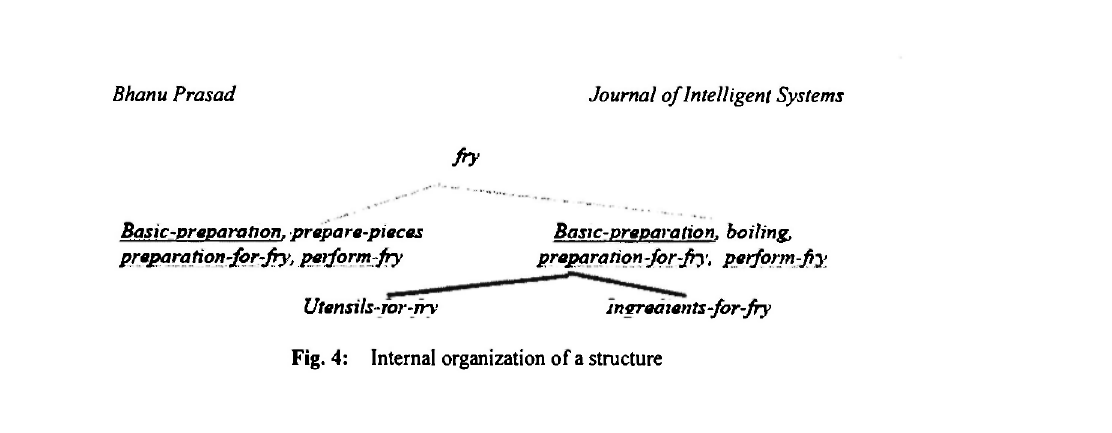
Fig. 4: Internal organization of a